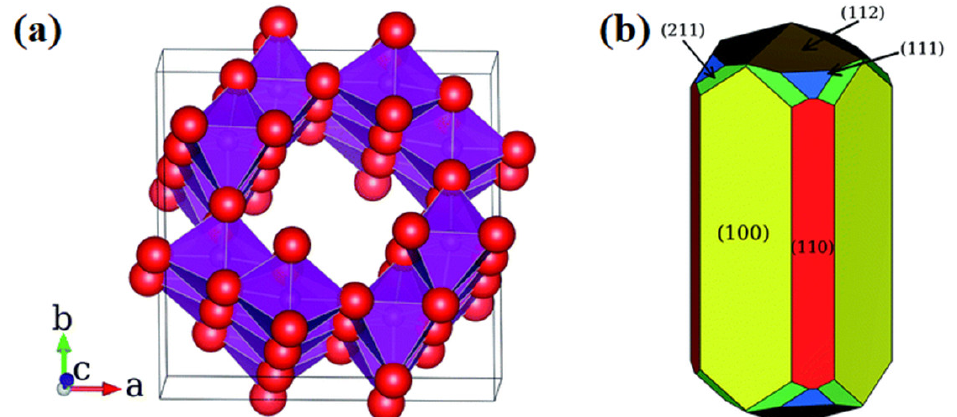
Figure 17. ( a ) Crystal structure of α-MnO 2 . Small (red) spheres are oxygen and large (purple) manganese lie inside the indicated approximate MnO 6 octahedra. Note the large 2 × 2 tunnel structures along the c -axis. ( b ) The predicted equilibrium crystal morphology for α-MnO 2 based upon the surface energies. (Reprinted from ref. [135] with permission from the Journal of Materials Chemistry A. Copyright © 2014, Royal Society of Chemistry).